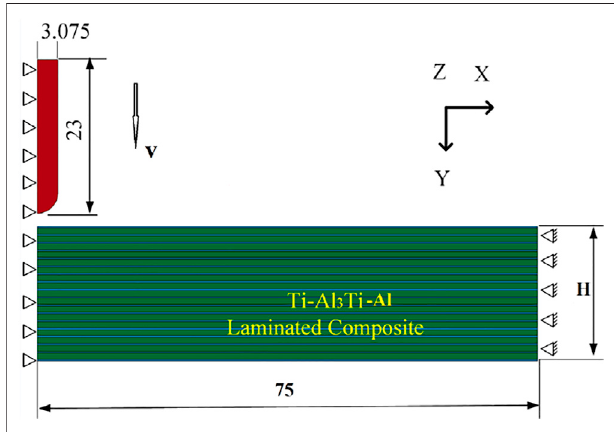
FIGURE 1 | Finite-element model of TC4-Al 3 Ti-Al laminated composite target (model parameters and constraints).